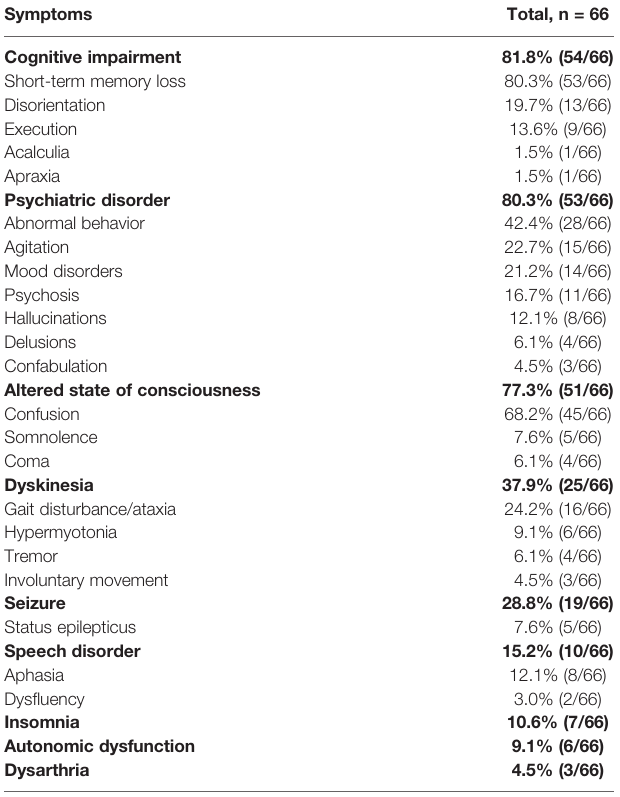
TABLE 2 | Summary of presenting symptoms.